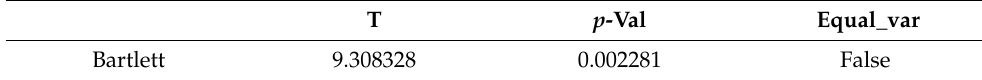
Table 4. Bartlett Homoscedasticity test.